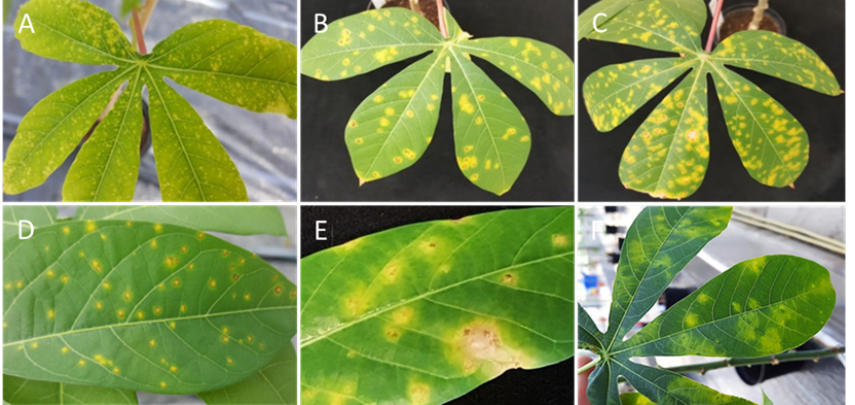
Figure 11. Differential response of cassava DSC 167 and TMS 96/0304 to infections with UCBSV- Ke125. The infection in DSC 167 starts with ( A ) yellow dots in the leaf that develop to ( B , C ) more significant yellow spots surrounded by necrotic spots. ( D , E ) Close-up of necrotic spots caused by UCBSV-Ke125. ( F ) Typical UCBSV-Ke125 symptoms on a susceptible TMS 96/0304.